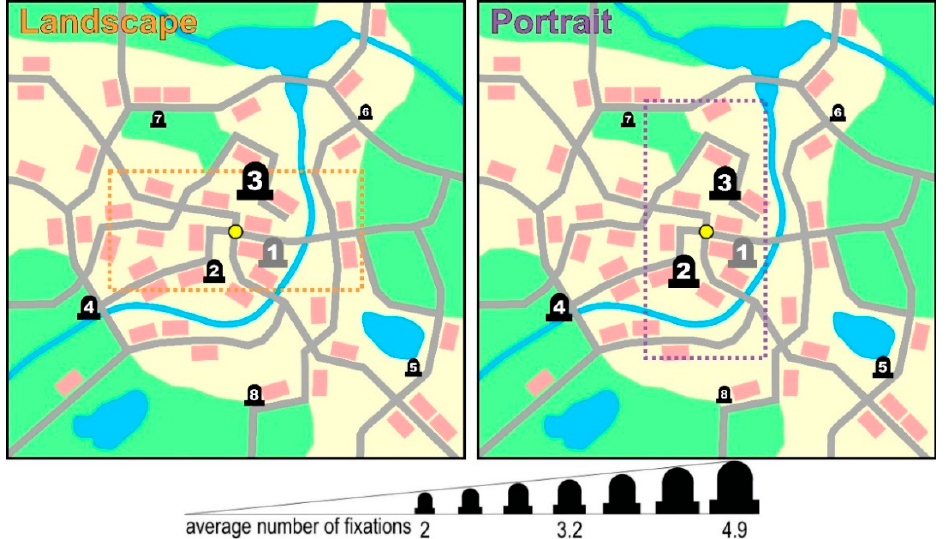
Figure 10. Proportional point symbols map with the presentation of the fixation on specific stone monuments.